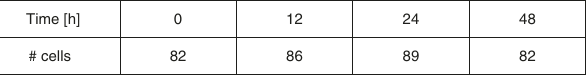
Hierarchical clustering of the SCRB-seq data (Supplementary Fig. 3) was performed using standard MATLAB routines. The particular clustering method was complete-linkage clustering using (1 — Pearson correlation) as the distance metric. correlations of an individual expression pro fi le with the average expression of mESCs, ectoderm-like cells at 96h and XEN-like cells at 96 h, respectively. For comparison with expression in in vivo tissue 21 we performed PCA on standardized in vivo data using the 829 most variable genes de fi ned above. We then projected our standardized SCRB-seq data on the plane spanned by the fi rst two principal